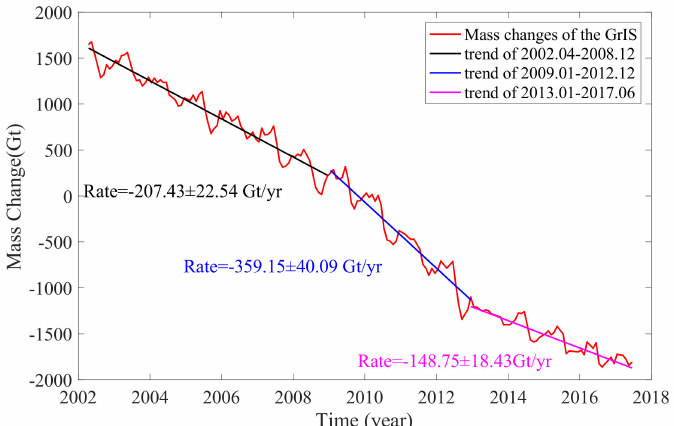
Figure 3. GrIS mass changes from GRACE between April 2002 and June 2017 after applying the forward modeling technique to suppress the ocean–land leakage e ff